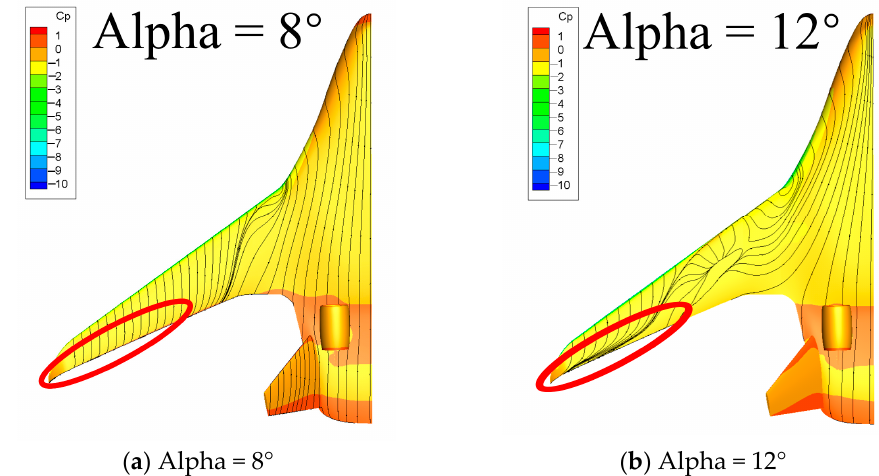
Figure 11. Upper surface limiting streamlines of the clean configuration.